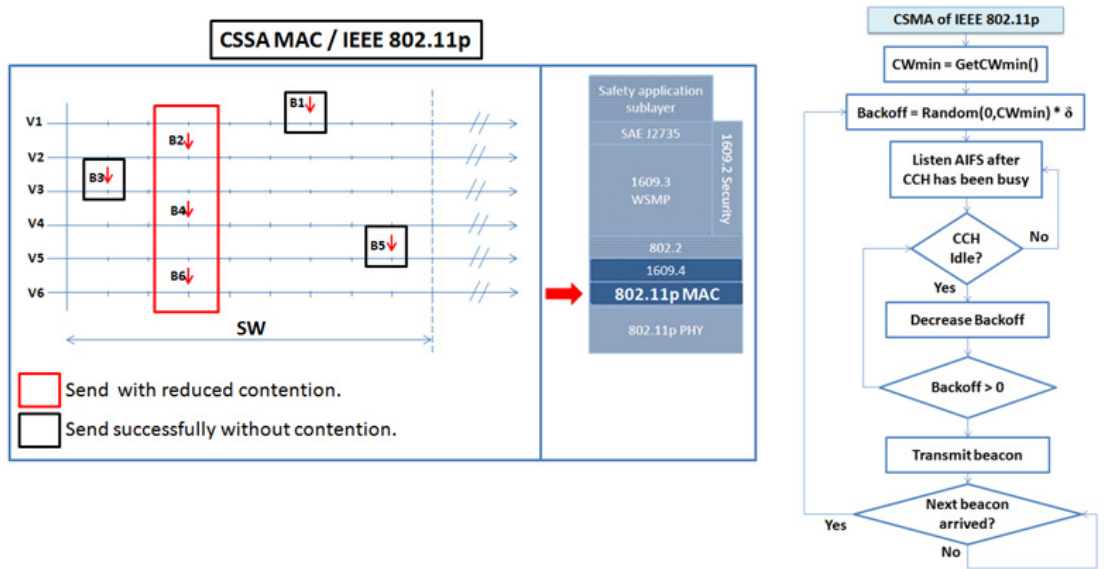
Figure 3. CSSA MAC functioning: beacons arriving to the IEEE 802.11p layer and being transmitted using the CSMA method.